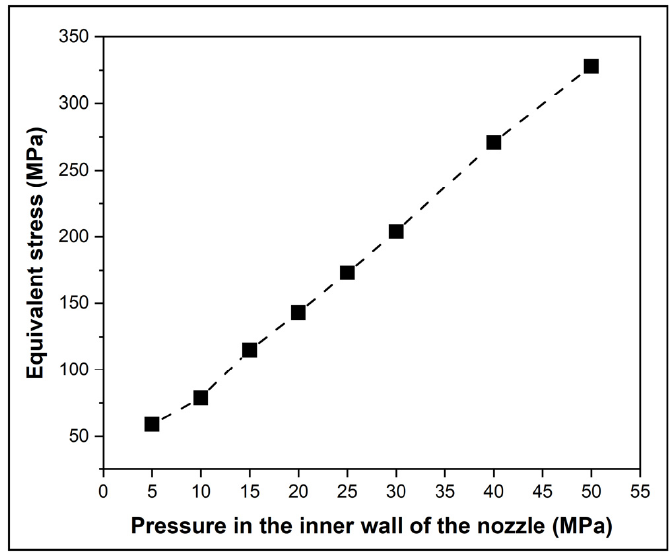
Figure 13. E ff ect of pressure in the inner wall of the nozzle on equivalent stress. Figure 13. Effect of pressure in the inner wall of the nozzle on equivalent stress.